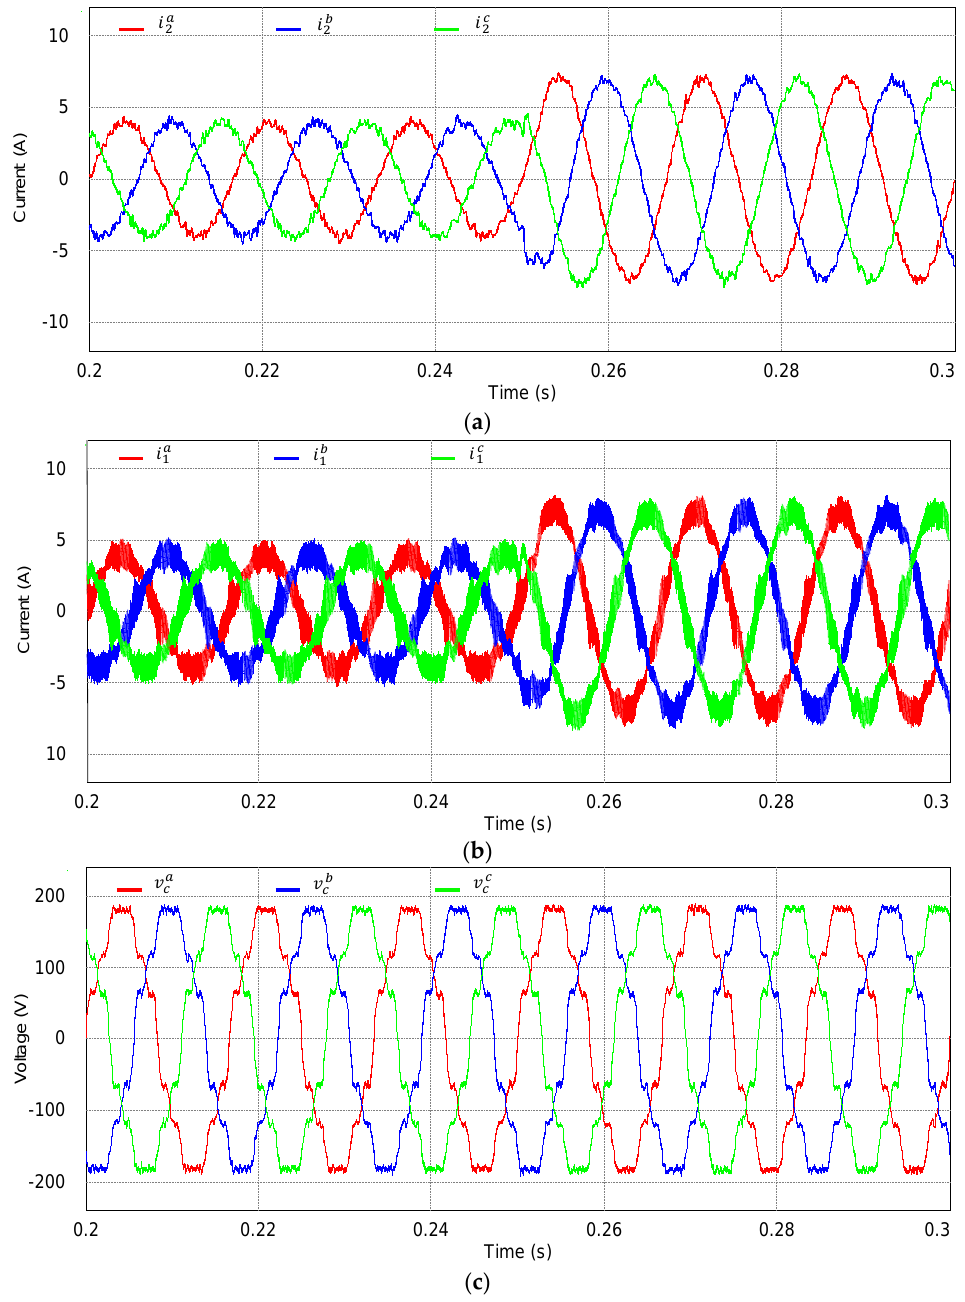
Figure 9. Simulation results for measured three-phase variables with the proposed control scheme under step change in q -axis current reference. ( a ) Three-phase grid-side current waveforms; ( b ) three-phase inverter-side current waveforms; ( c ) three-phase capacitor voltage waveforms. currents, inverter-side currents, and capacitor voltages under the same condition of Figure 9. In